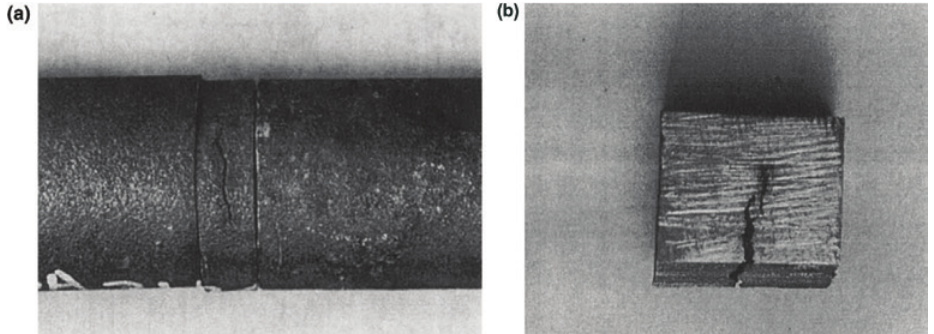
Fig. 7: Circumferential crack at (a) outer surface and (b) inner surface